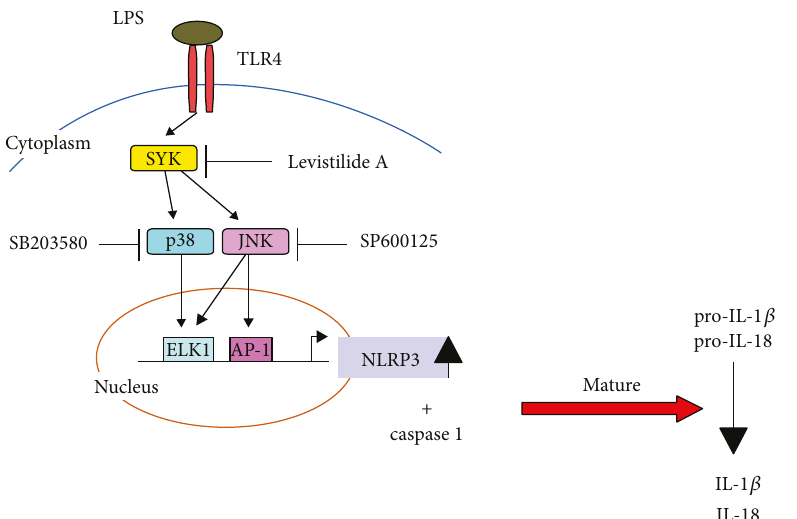
Figure 6: LA anti-in fl ammatory mechanism diagram. LA inhibited the activity of p38/JNK by decreasing Syk phosphorylation, thereby inhibiting the downstream NLRP3 in fl ammasome gene expression and the secretion of its related proteins (IL-1 β and